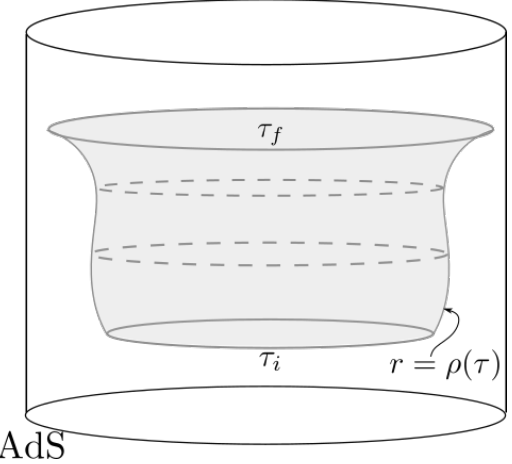
Figure 8: The subregion of Euclidean global AdS whose gravitational action we pro- pose to be the cost of the path integral on the finite cutoff